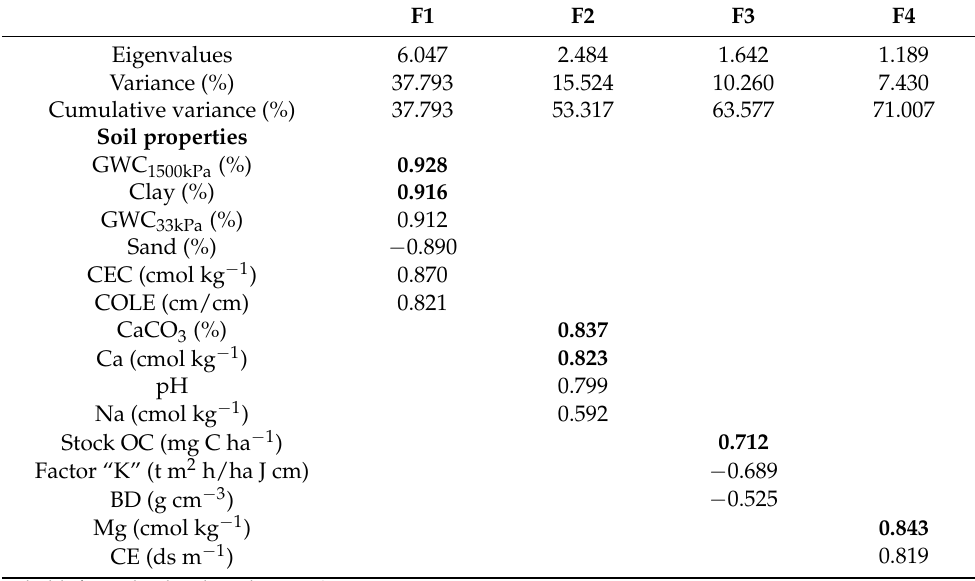
Table 3. Reordered matrix of rotated factors.